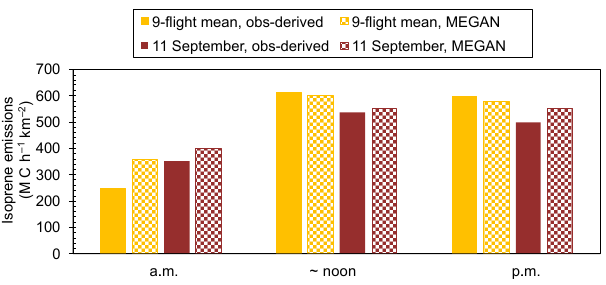
Figure 8. Temporal variability (a.m.: 15:00–16:00UTC; ∼ noon: 18:00–19:00UTC; p.m.: 20:00–21:00UTC) of isoprene emissions in Conroe averaged on multiple DISCOVER-AQ flight days in September 2013 from NUWRF–MEGAN and aircraft observations, compared with the 11 September 2013 conditions. The multi-flight day mean P-3B isoprene, NAQFC CMAQ OH, and NUWRF PBLH were used to derive the multi-day mean observation-based emis- sions. The NUWRF model data are from the 12km control